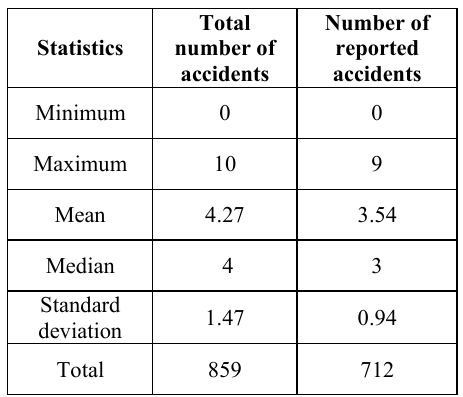
Table 2. The accidents’ summary statistics .